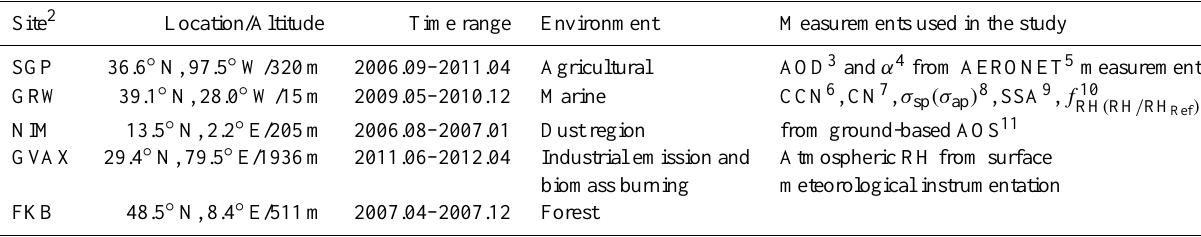
Table 1. Description of ARM 1 data sets selected for this